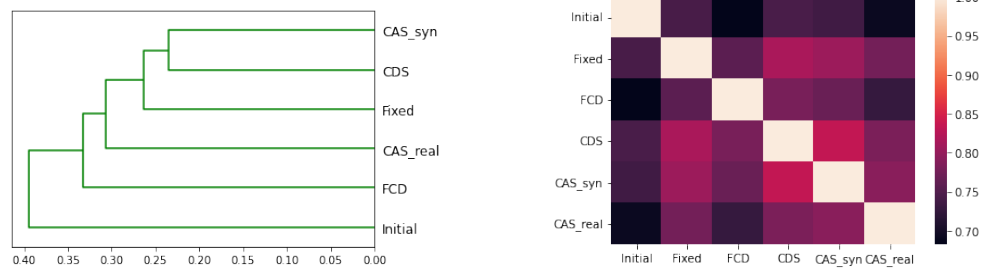
Figure 20. The Pearson correlation heatmap and dendrogram plots of the minority class of the experiments on all tabular